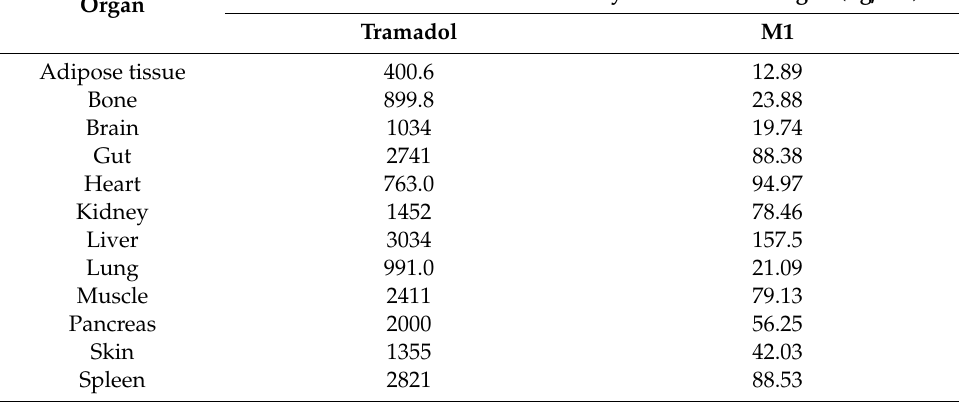
Table 5. Maximum simulated concentrations at steady-state for tramadol and O -desmethyltramadol (M1) in each organ (C max,ss ) after oral administration of 100 mg tramadol ER tablet twice daily (five times in